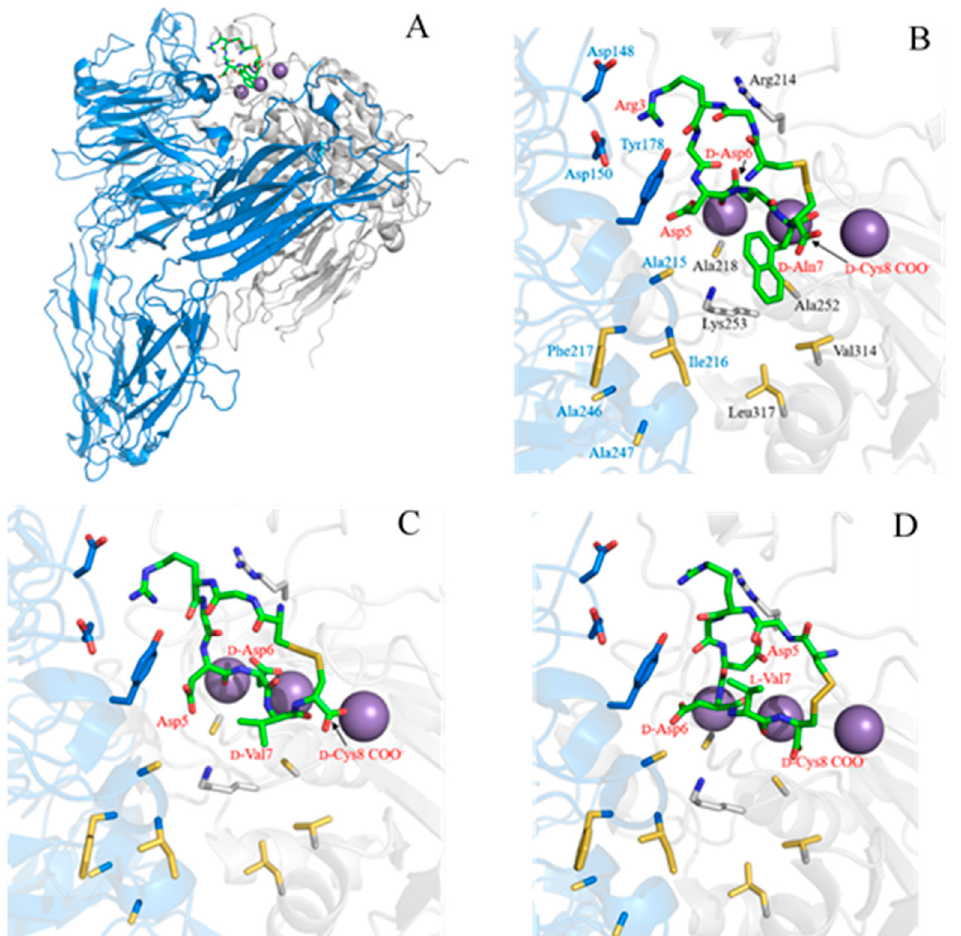
Figure 4. Docking models of LXW analogs (LXW64, LXW7 and LXW11) with α v β 3 integrin. ( A ) LXW64 (green) bound to α v β 3 integrin ( α -subunit: blue, β -subunit: grey, Mn 2+ : purple); ( B ) Closeup view of LXW64 (green sticks) in the α v β 3 integrin binding site. Key amino acids are labeled with blue in α -subunit, black in β -subunit, and red in LXW64; ( C ) Closeup view of LXW7 (green sticks) in the α v β 3 integrin binding site. Key amino acids are highlighted with the same labels as in Figure 4 ( B , D ) Closeup view of LXW11 (green sticks) in the α v β 3 integrin binding site. Key amino acids are highlighted with the same labels as in Figure 4B.